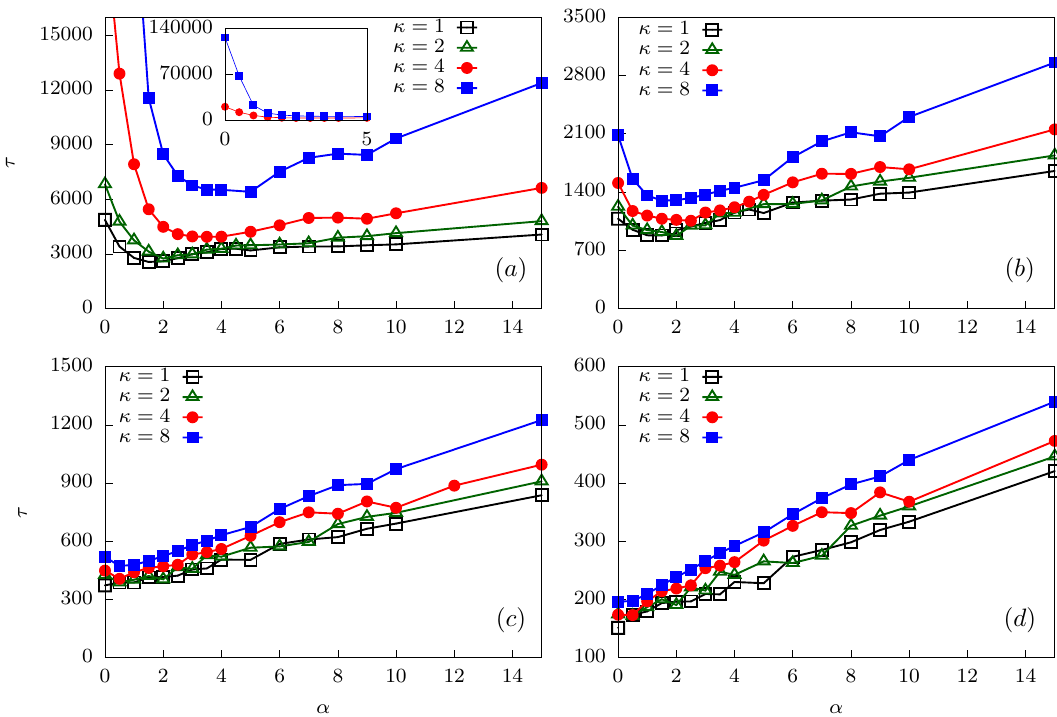
Figure 9. Total translocation time versus α for a semiflexible polymer for four different bending rigidties κ = 1, 2, 4 and 8. In ( a ) the variation is shown for f 0 = 0.2 . (Inset) Magnified plot at lower α for κ = 1.0 and 2.0. As external force is increased : ( b ) f 0 = 0.5 , ( c ) f 0 = 1.0 and ( d ) f 0 = 2.0 , τ increases almost linearly with α